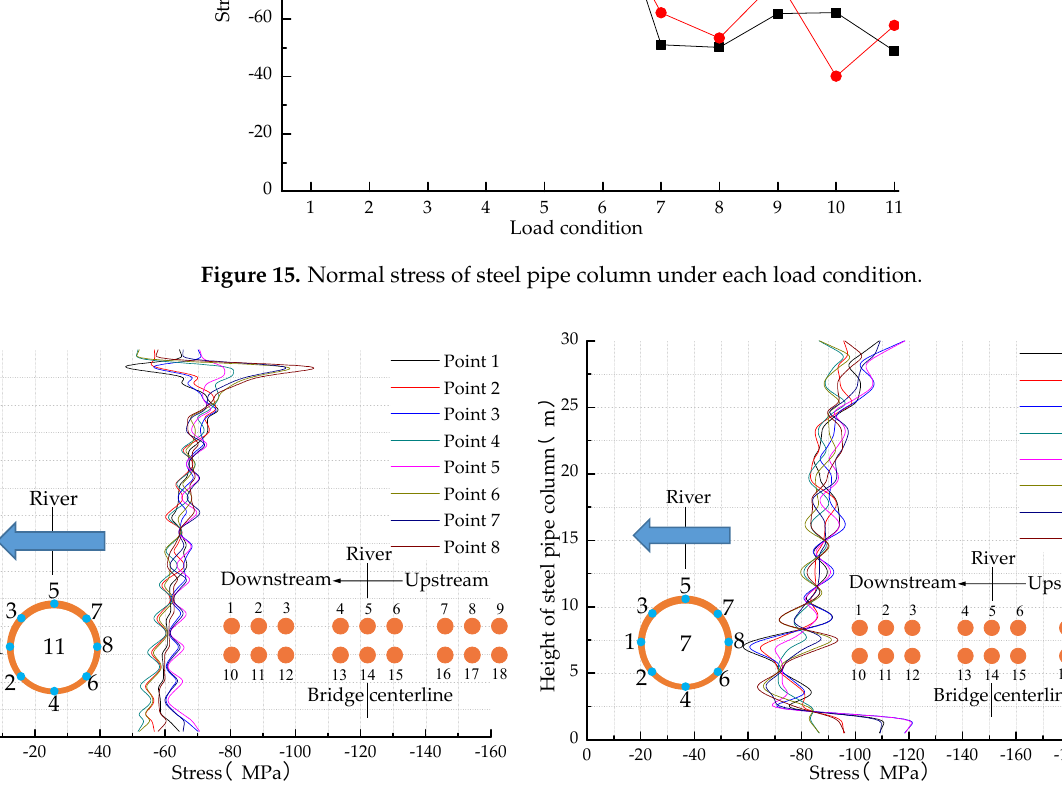
Figure 16. The changing tendency of normal stress with height for steel pipe columns: ( a ) No. 11 steel pipe column; ( b ) No. 7 steel pipe column.